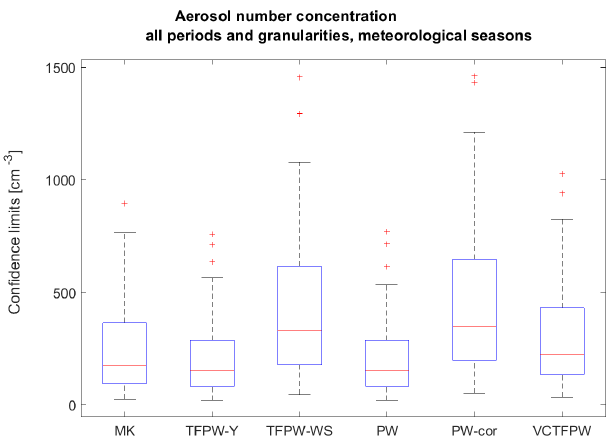
Figure 5. Distribution of the confidence limit intervals of the slope for the trend in aerosol number concentration for all periods (5– 24 years) and time granularities (1d–1 month) as a function of the method for the meteorological season temporal segmentation. Box– whisker plotting as described for Fig.